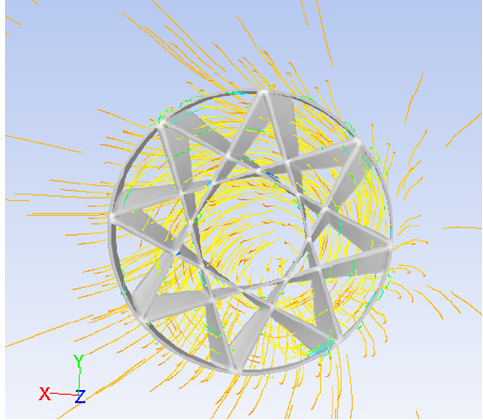
Figure 6. Path line diagram of the turbine in a free flow speed of 4